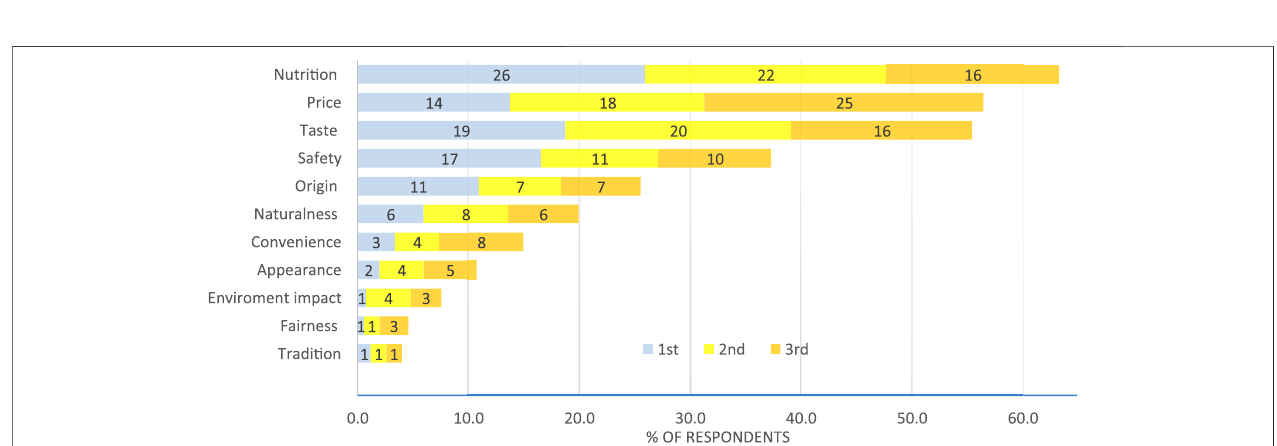
FIGURE1| Topthreefoodvalues.Note:Consumerswerepresentedwitharandomlistandaskedtoselectthetopthreechoicesintermsofvalueoffoodchoices. Nutrition (nutritional food quality), Price, Taste, Safety (con fi dence in Canada ’ s food safety system), Origin (where the food was grown or produced), Naturalness (the degree to which food has been altered), Convenience (of use), Appearance, Environmental impact (effect on biodiversity), Fairness (of production), Tradition (historical precedence).